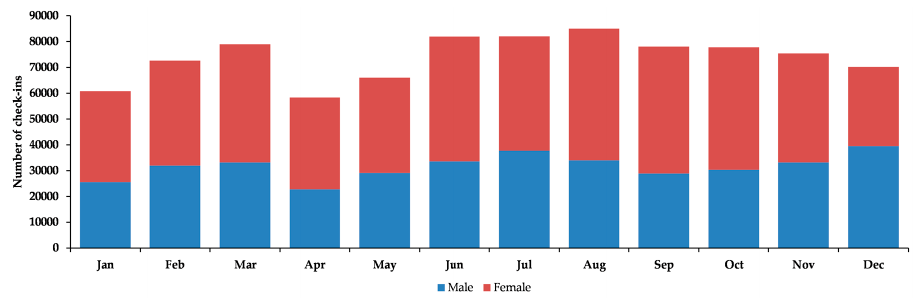
Figure 3. Sex-based monthly check-in distribution in Shanghai.